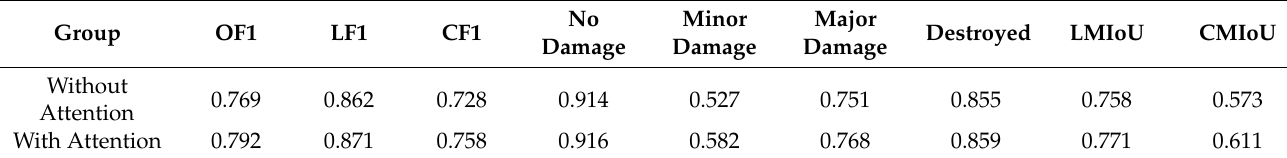
Figure 13. The fusion result of hurricane-michael_00000256, palu_00000004 and palu_00000181. ( a ) The GT of hurricane-michael_00000256, ( b , c ) the results of the model w/o A and model w A of hurricane-michael_00000256, ( d ) the GT of palu_00000004, ( e , f ) the results of the model w/o A and model w A of palu_00000004, ( g ) the GT of palu_00000181 and ( h , i ) the results of the model w/o A and model w A of palu_00000181. Table 6. Fusion result